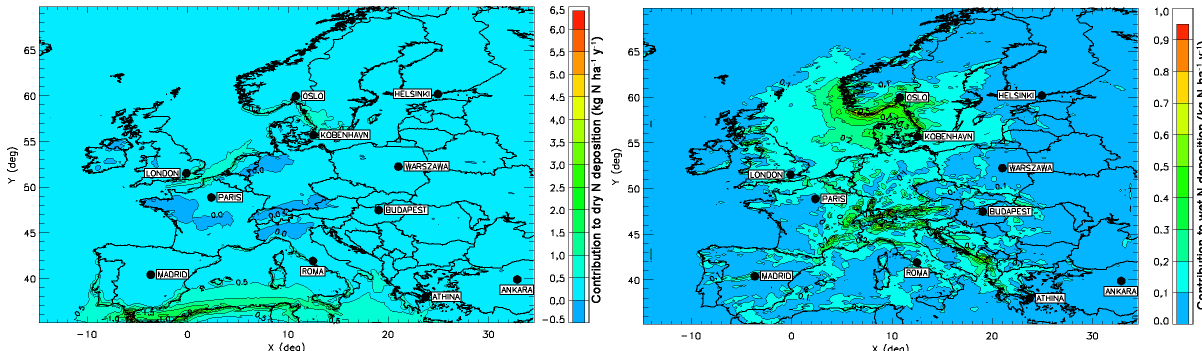
Figure 8. Contribution of ship emissions to the annual dry N deposition (left) and wet N deposition (right) (base case − no